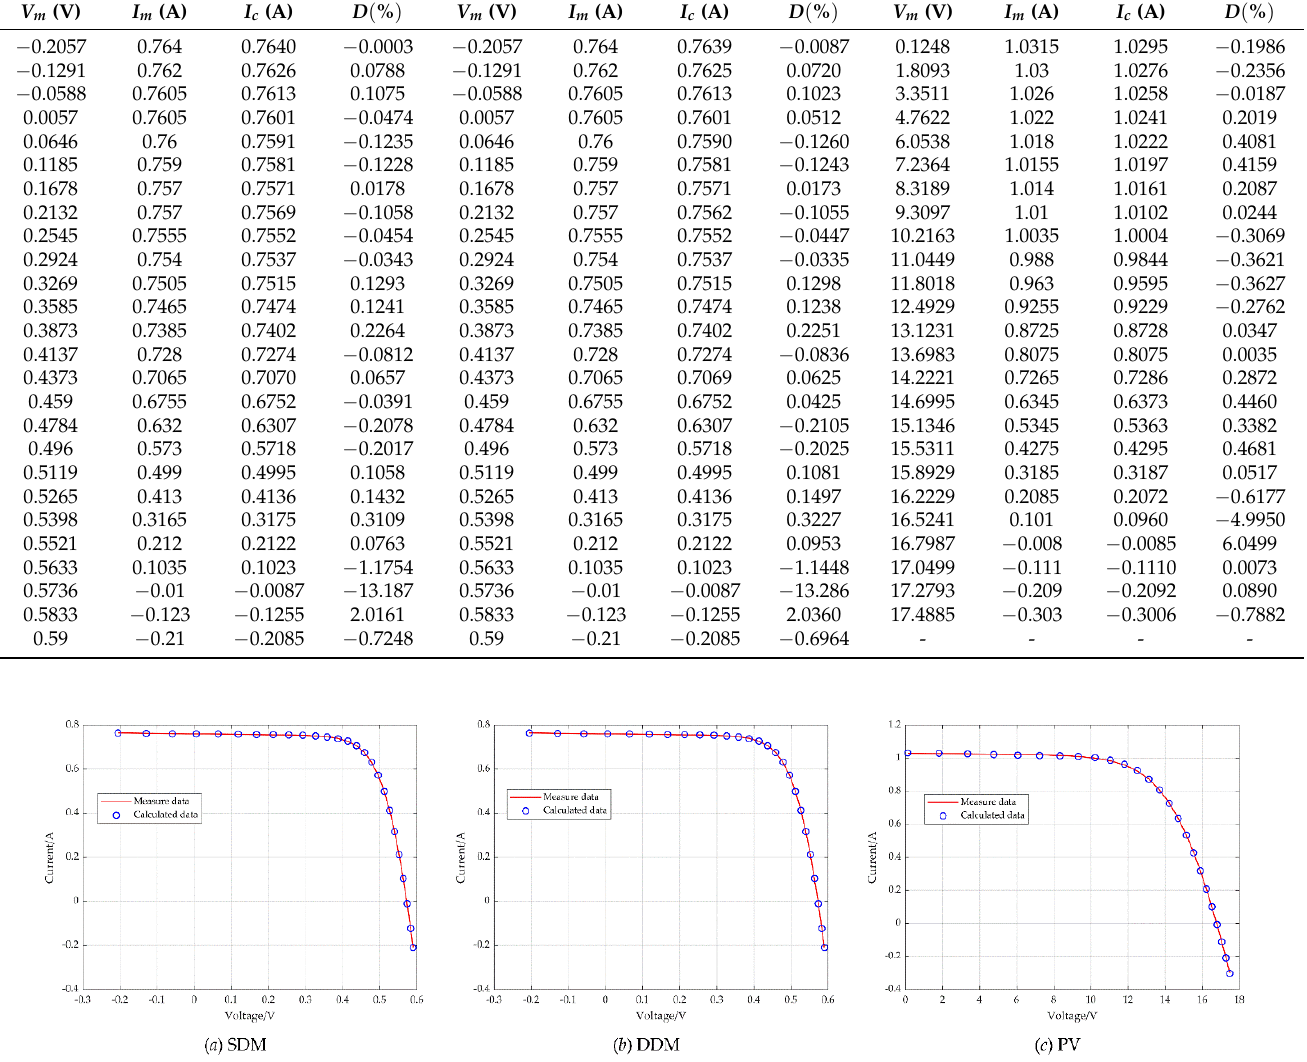
Table 6. Simulation results of using the DCWPA for three models solution.